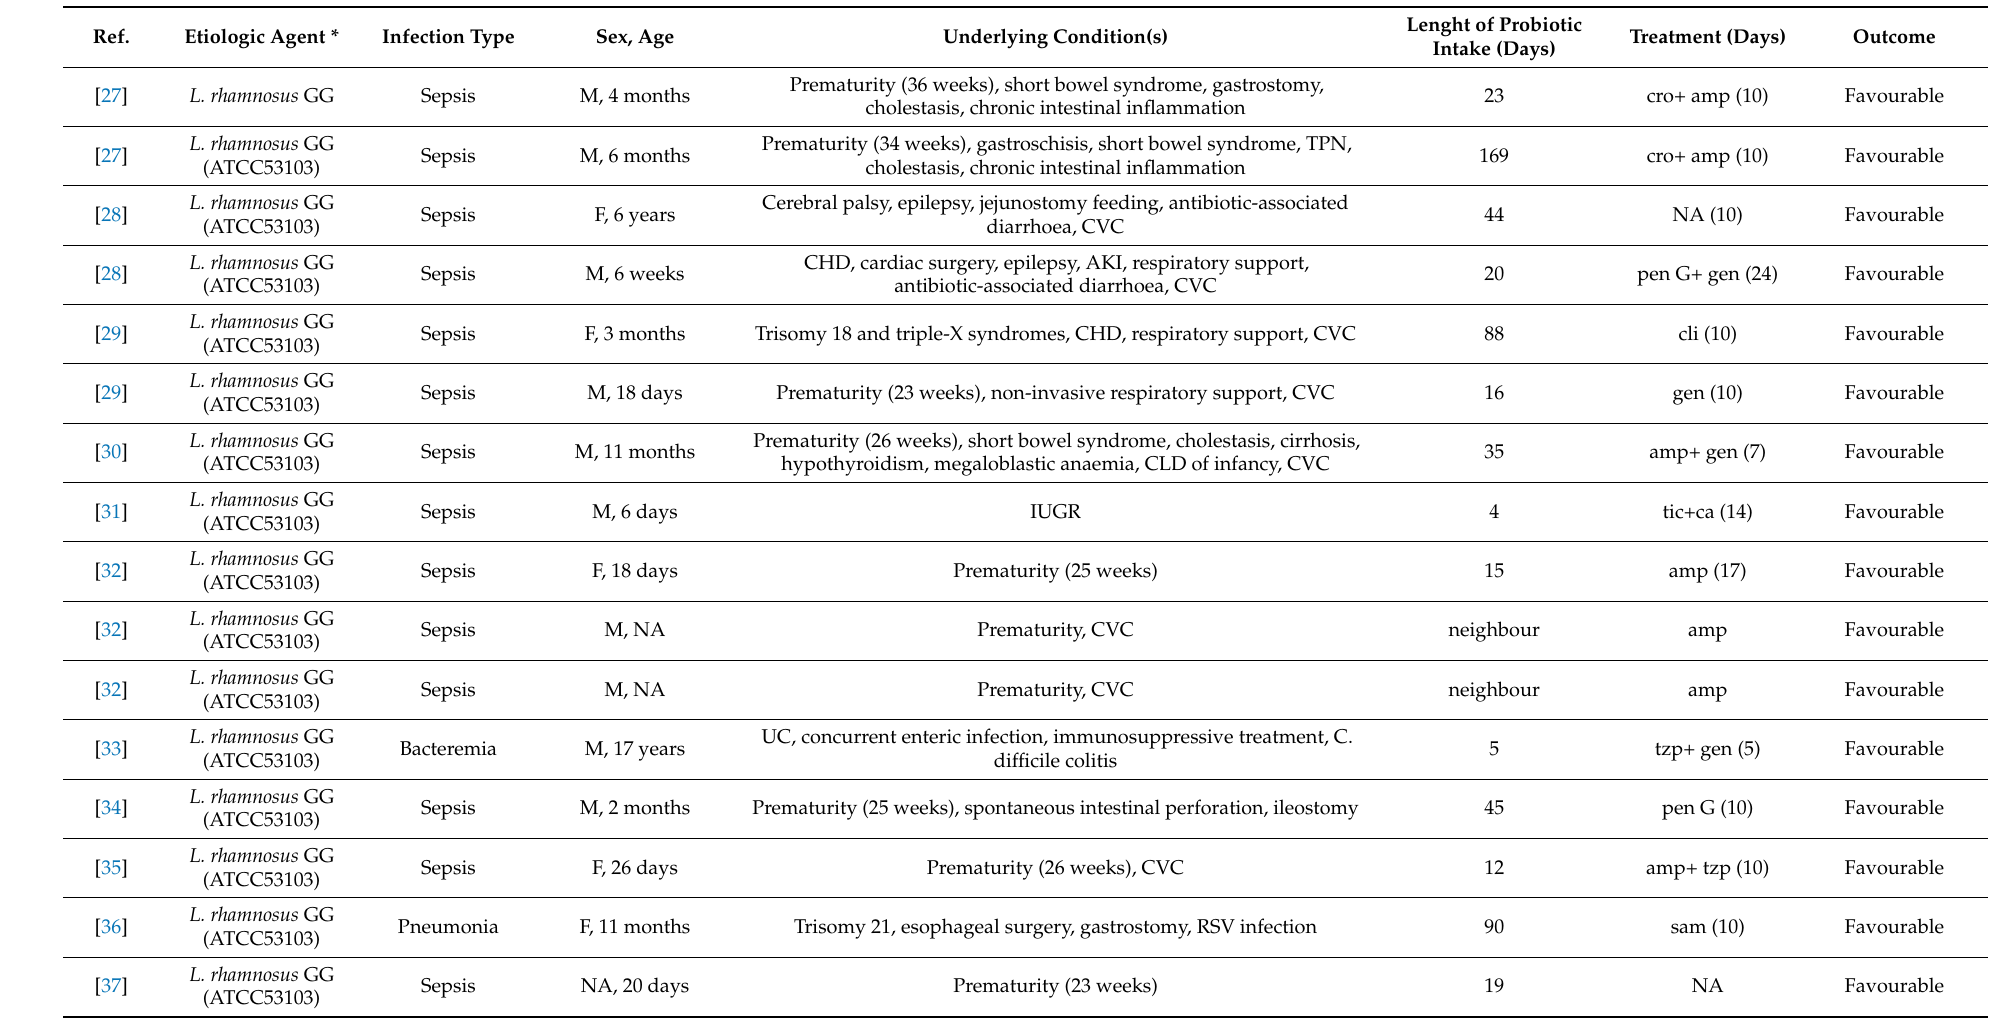
Table 1. Clinical and microbiologic features of 17 paediatric patients with Lactobacillus spp. ( L. spp.) invasive infections after use of probiotics.